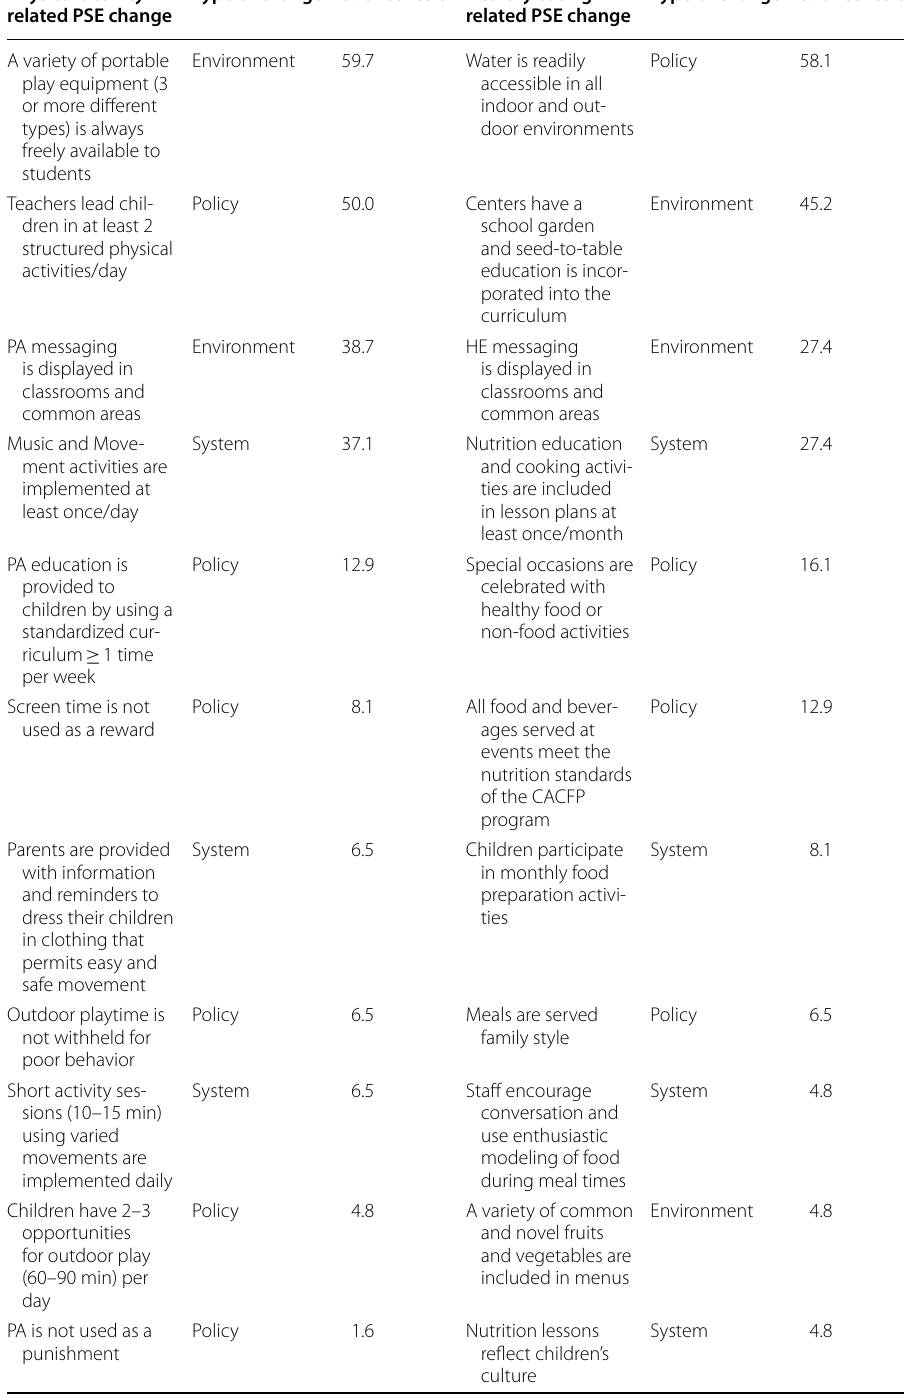
Table 3 Physical activity and healthy eating-related PSE changes implemented by ECE centers ( n 68 ECE =